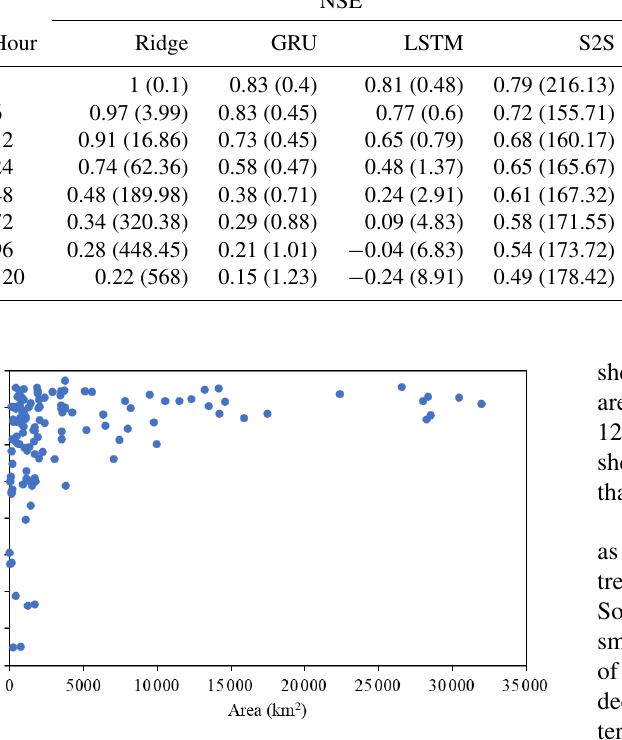
Figure 7. The distribution of the 120h ahead prediction using the best model in our benchmark (GRU for the single